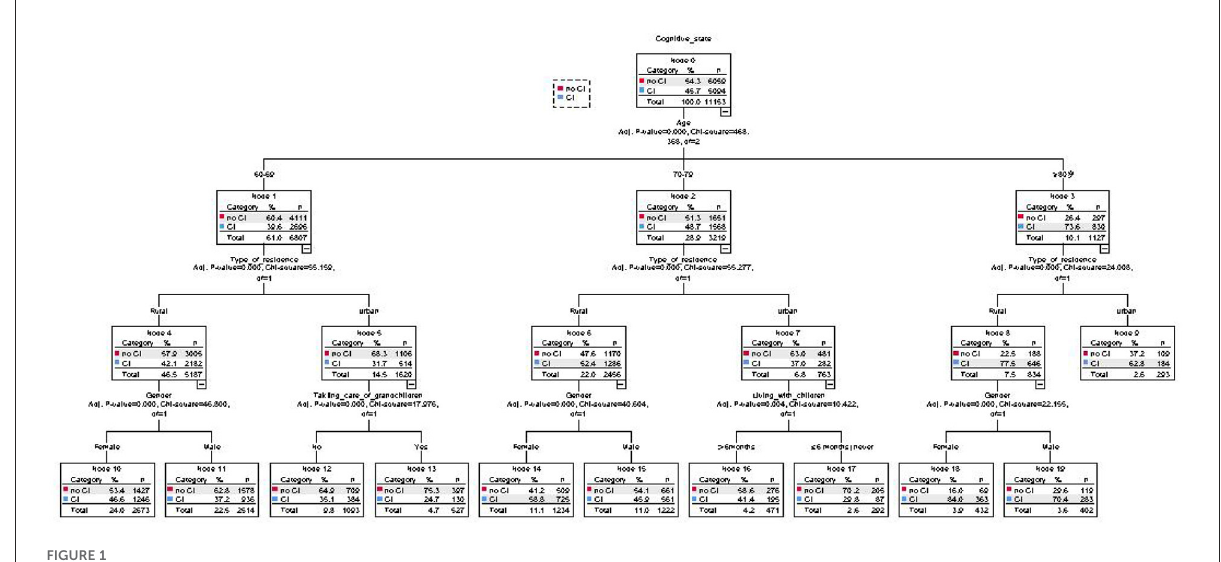
FIGURE1 Decision tree analysis of the factors correlated cognitive impairment among older adults in